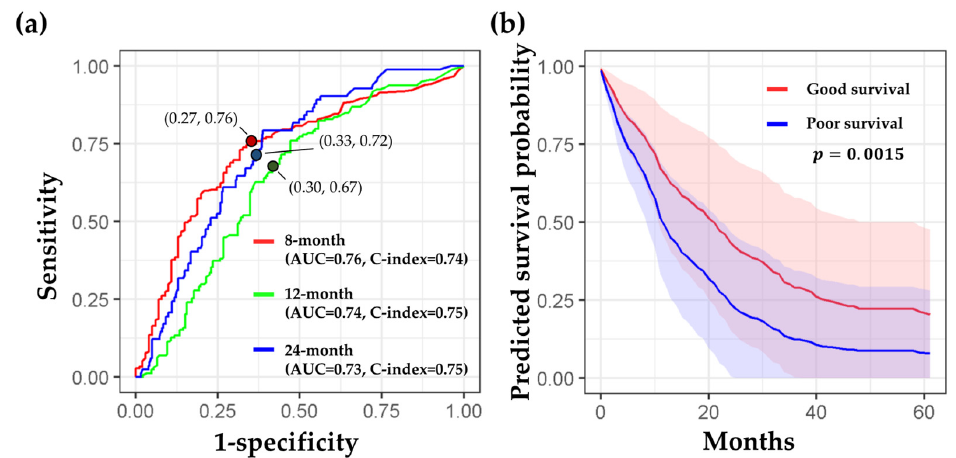
Figure 4. Detailed performance of the combined model (radiomic + clinical features). ( a ) Time-dependent ROC curves at 8, 12, and 24 months. Red, green, and blue lines correspond to ROC curves while predicting patients’ survival duration longer than 8, 12, and 24 months, respectively. The red, green, and blue dots are located with the values of “1-specificity” and “sensitivity,” which were estimated with the three optimal probability thresholds (0.65, 0.51, and 0.35) at 8, 12, and 24 months, respectively. ( b ) The mean survival curves from the good (red) and poor (blue) survival groups were displayed. The significance of the predicted survival probability between the two groups was assessed using a log-rank test.